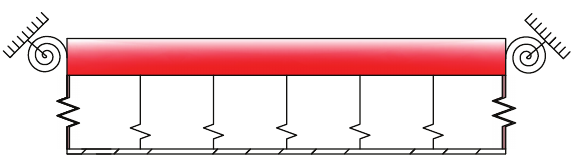
Figure 1: The beam on elastic foundation with elastically restrained